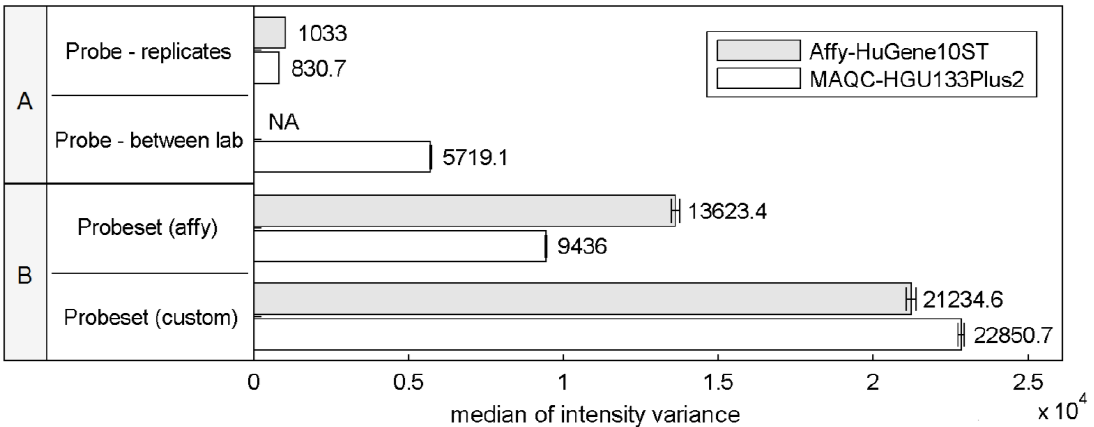
Figure 1. Median of signal intensity variance in two microarray experiments MAQC-HGU133Plus2 and Affy-HuGene10ST with 95% CI. ( A ) median of individual probe intensity variance between biological replicates from a single or various laboratories ( B ) median of probe intensity variance in a single probeset defined using a standard CDF file or a redefined custom CDF based on the up-to-date transcript nucleotide sequence data